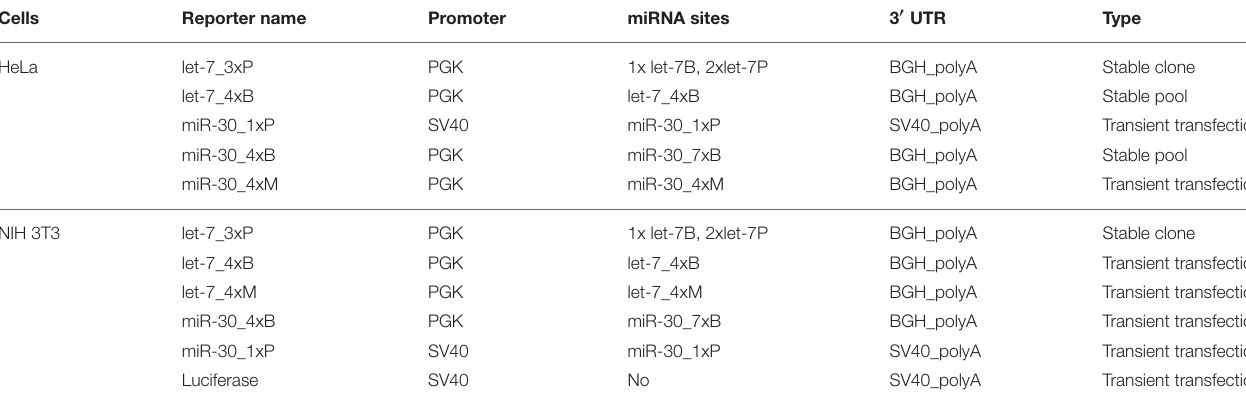
TABLE 1 | Firefly luciferase reporters used in HeLa and NIH 3T3 cells.